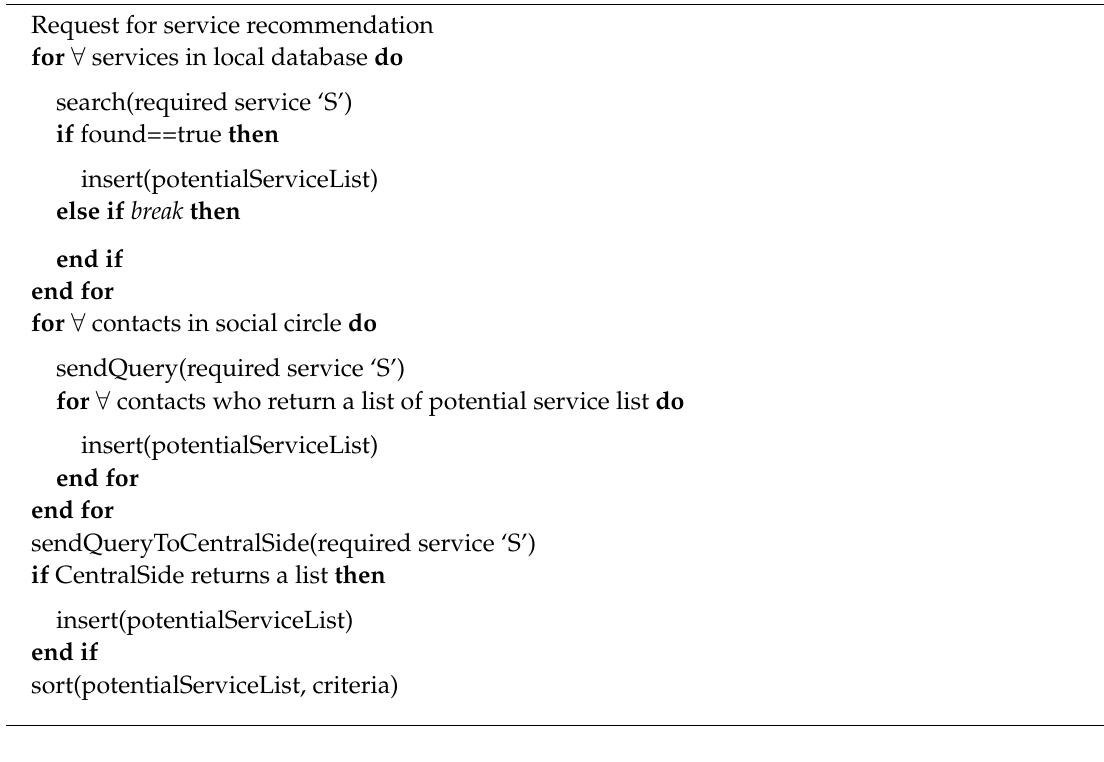
Algorithm 3 Interaction between the nodes